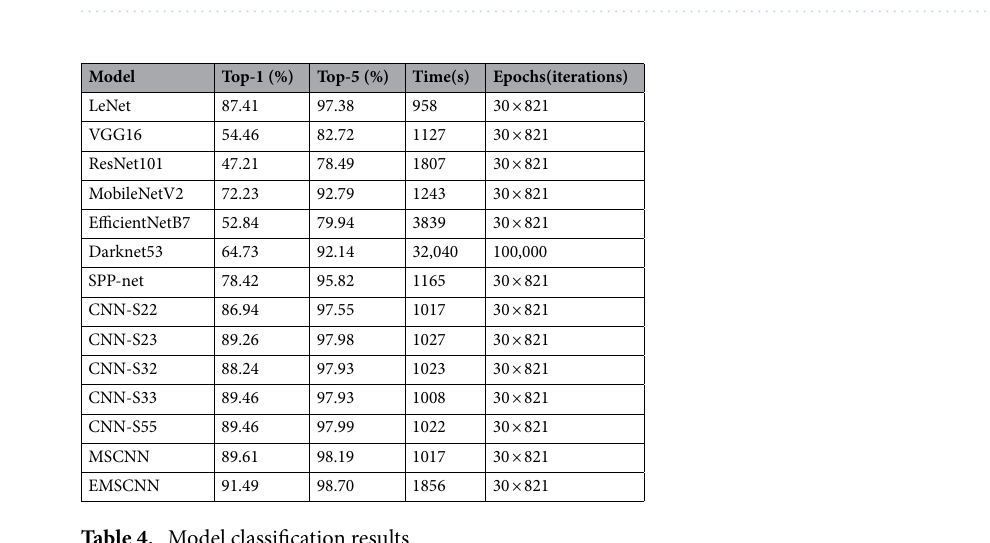
Table 3. CNN model structure parameters.